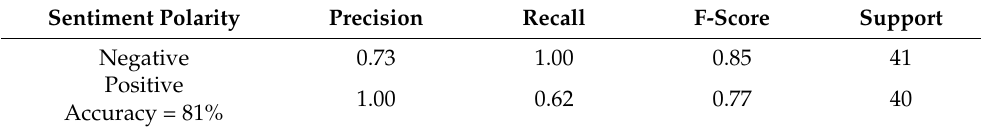
Table 2. Performance evaluation of final data with positive, negative, and neutral sentiments. Sentiment Polarity Precision Recall F1-Score Support Negative 1.00 0.25 0.40 Neutral 0.67 1.00 Positive 1.00 Accuracy = 71% Table 3. Performance evaluation of data set with positive, negative sentiments with 20% test data. Sentiment Polarity Precision Recall F-Score Support Negative 0.73